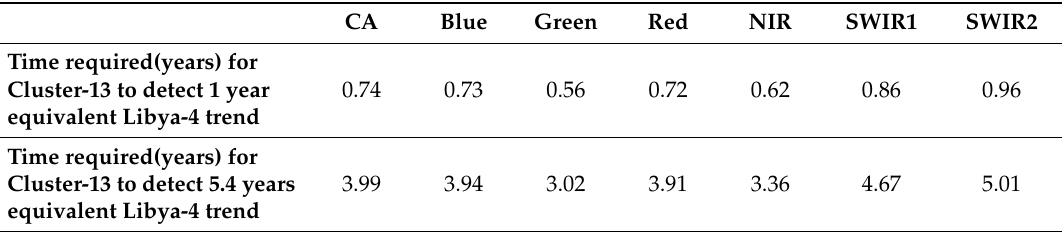
Table 9. Trend detection time improvement by EPICS compared to Libya-4. CA Blue Green Red NIR SWIR1 SWIR2